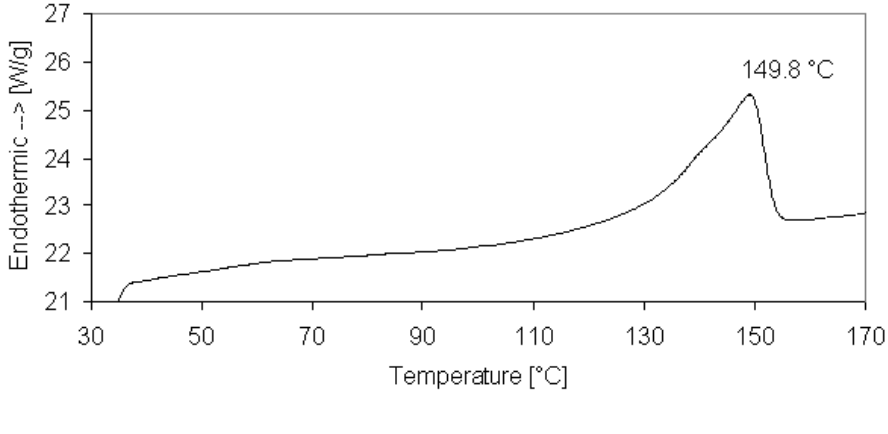
Figure 4. DSC scan of the thermoplastic